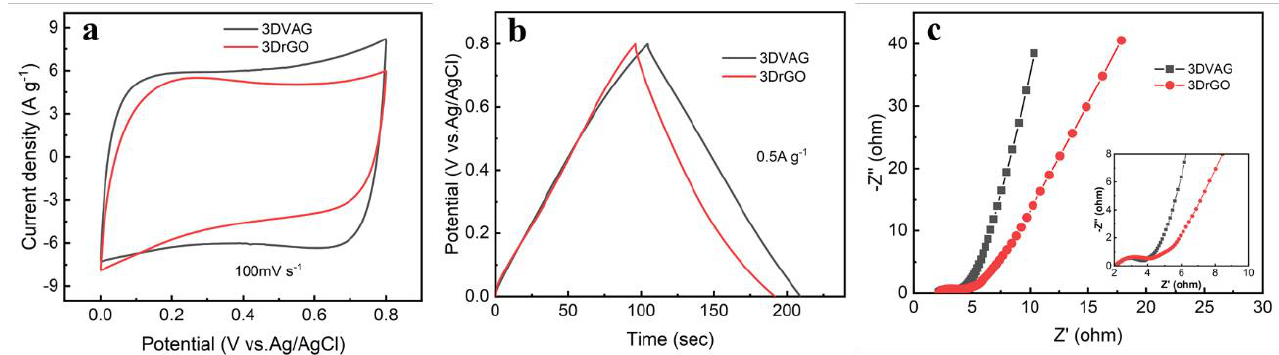
Figure 8. Electrochemical performance of 3DVAG and 3DrGO in a three − electrode system: ( a ) CV; ( b ) GCD; ( c ) EIS.